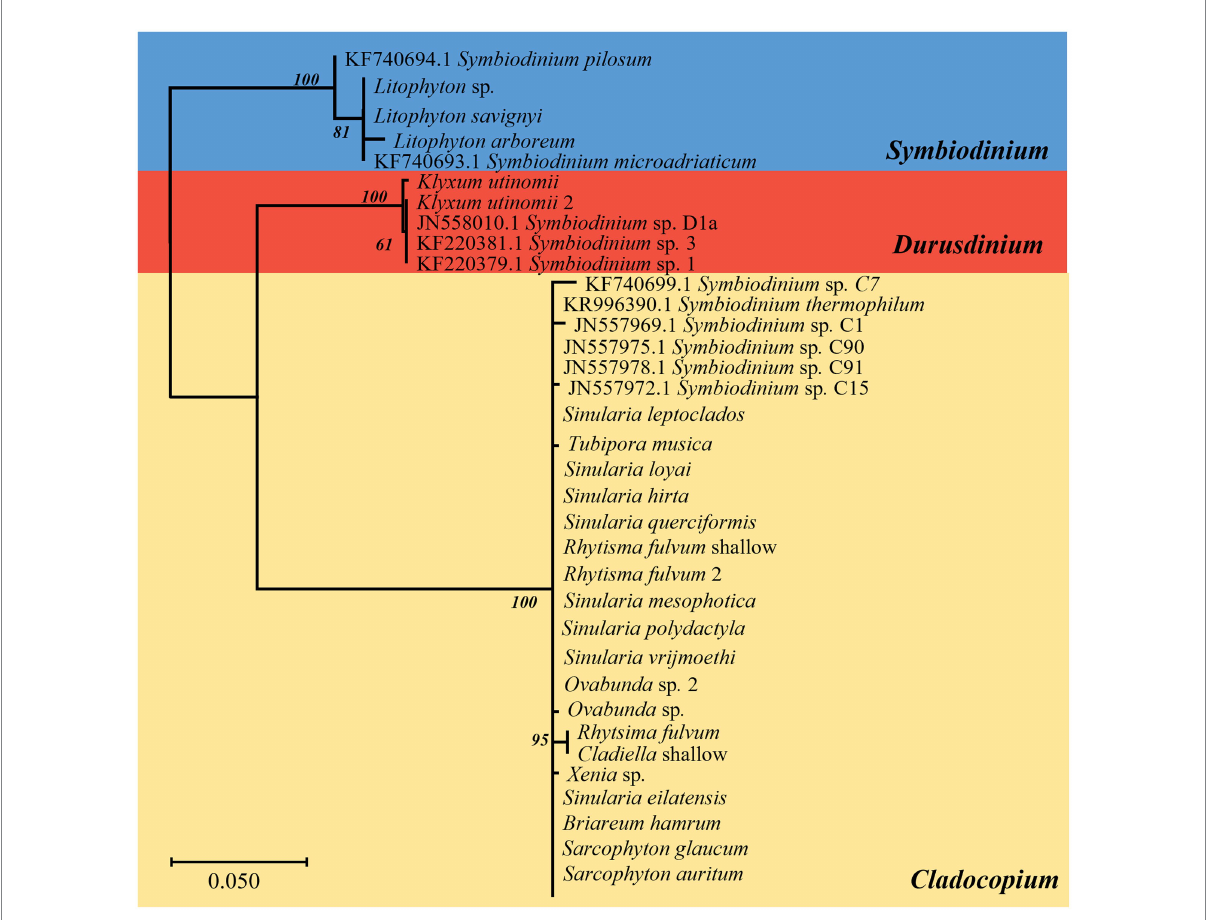
FIGURE 1 Phylogenetic relationship of Symbiodiniaceae based on chloroplast 23S rRNA sequences (500 bp) under the HKY + F model. The maximum likelihood tree was reconstructed with IQ-TREE 2.1.3. ML bootstrap support based on 1,000 replicates are indicated either above or below the corresponding branch. Colors represent different Symbiodiniaceae genera: blue Symbiodinium algae, red Durusdinium algae, and yellow Cladocopium algae. Species that presented a variation in the obtained sequence are indicated by the number 2. For the obtained new Symbiodiniaceae sequences, the host name is indicated rather than the algal